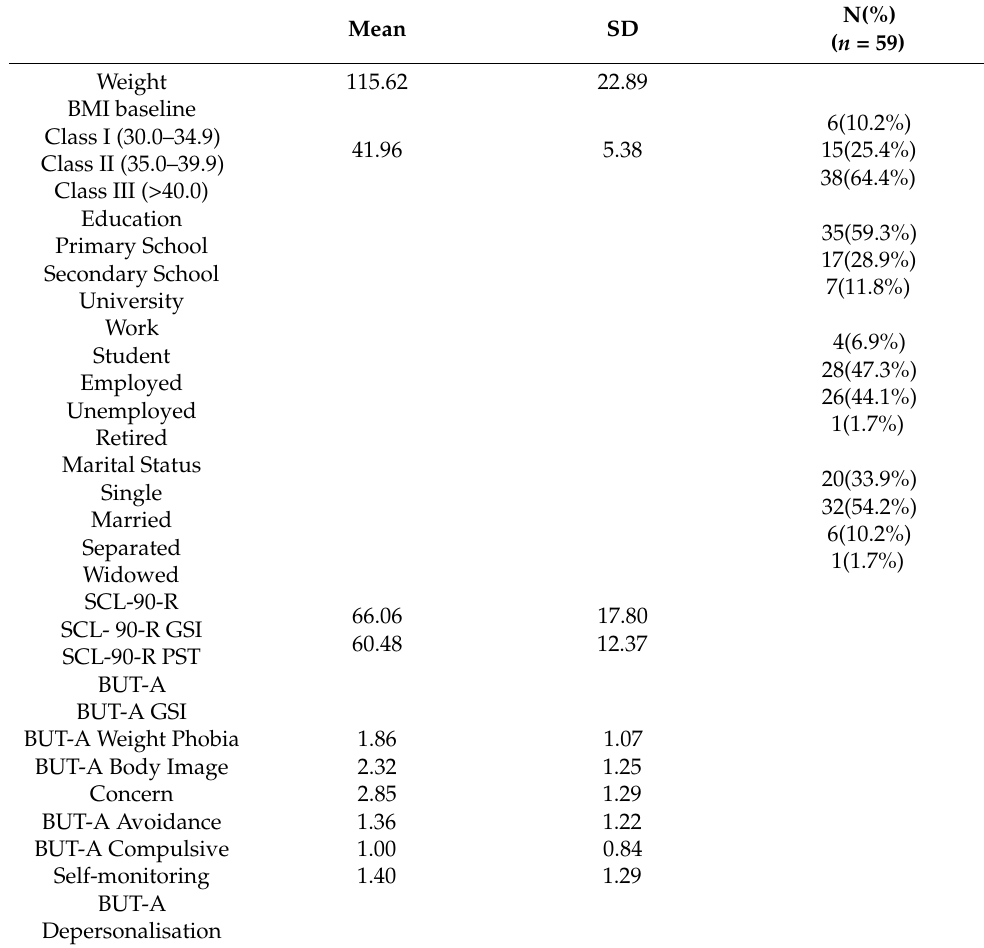
Table 1. Sociodemographic and psychological characteristics of participants (n =